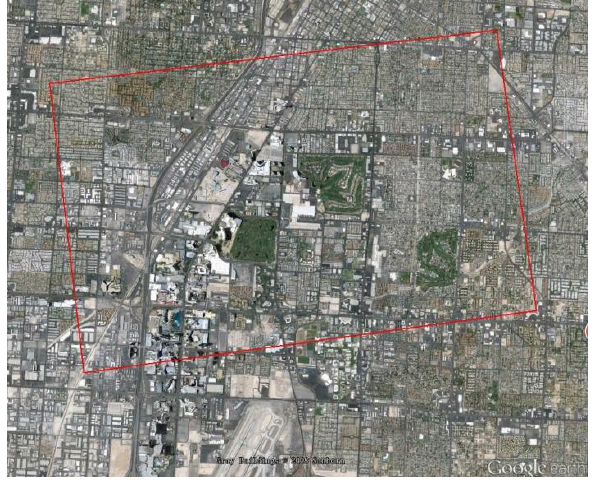
Figure 2. The area of test data in Las Vegas marked with a red rectangle